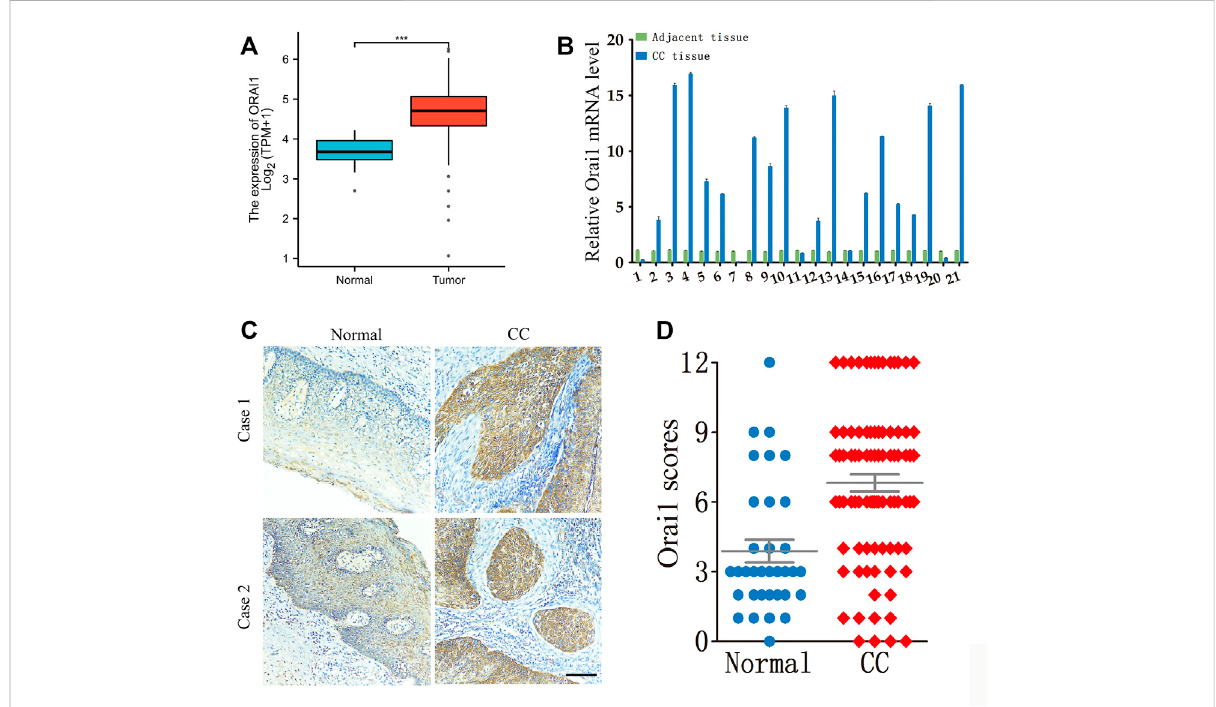
FIGURE 1 Orai1 isupregulated incervicalcancer. (A) Relative Orai1mRNA expressioninthecervicalcancer ( n = 306) andnormalcervical ( n =13)samples from TCGA RNA-seq data. (B) Relative Orai1 mRNA levels in 21 paired tumor and normal tissues from cervical cancer patients. (C – D) Representative images and IHC results for Orai1 protein expression in normal ( n = 34) and cervical cancer (CC) tissues ( n = 87). Scare bar = 100 μ m *** p <